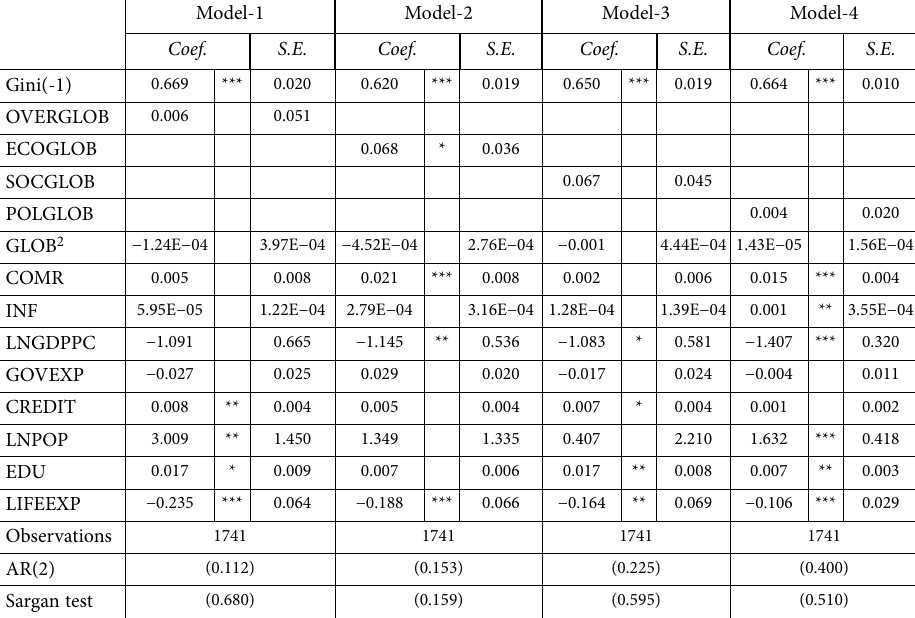
Table A5. Income inequality and globalization, dynamic GMM analysis (an additional squared term and country risk) Model-1